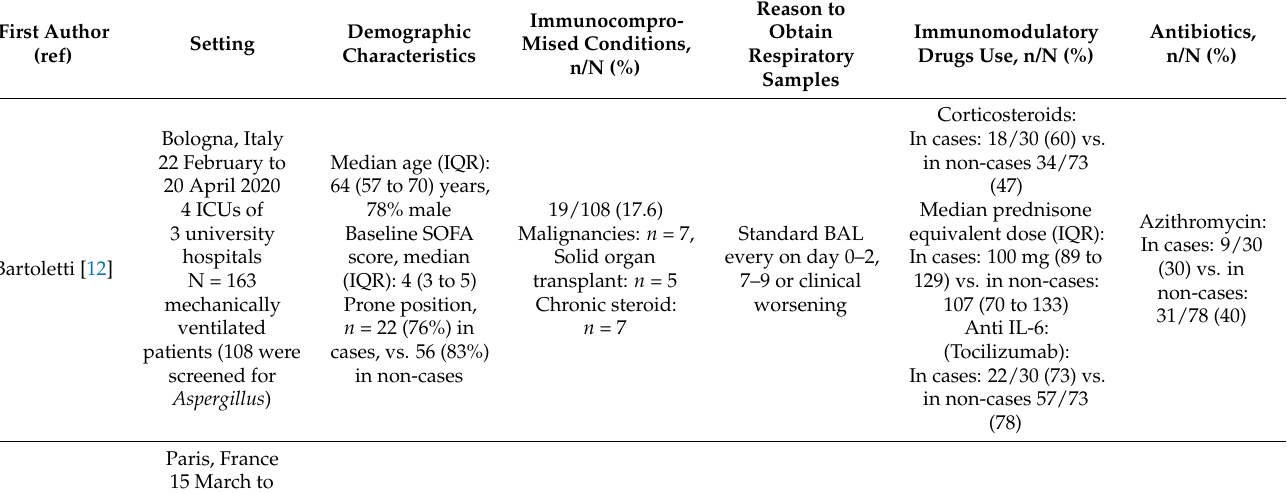
Table 1. Demographic and clinical characteristics of the included studies (cases: what later deemed to fulfil the criteria for the clinical entity, non-cases: not fulfilled clinical entity criteria), ordered by alphabetical order of first author’s